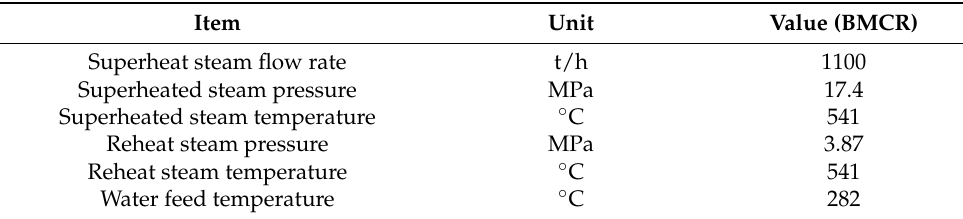
Figure 1. Schematic diagram of the 300 MW CFB boiler. Table 1. Design parameters of the 300 MW CFB